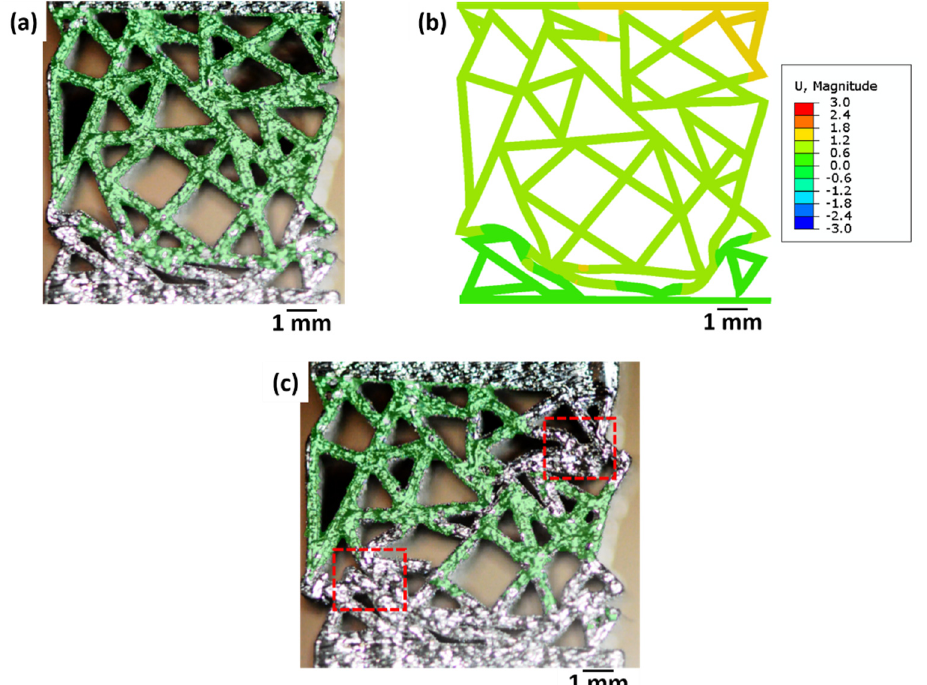
Figure 7. Strain distribution in the non-nested cellular solid sample was measured by ( a , c ) DIC; and ( b , d ) FEM simulation. The strain distribution in ( a , b ) is plotted at 12% strain (red point 2, Figure 4b), and the strain distribution in ( c , d ) is plotted at 20% strain (red point 4, Figure 4b). Red rectangles in ( c ) show the failure of nodes; FEM simulations predict only the strain magnitudes.